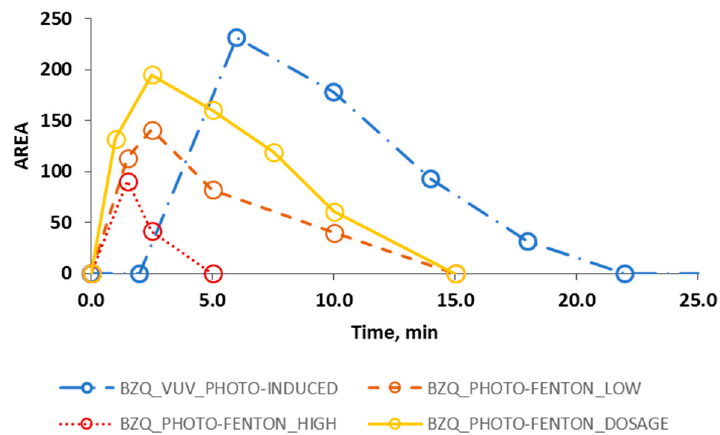
Figure 4. Evolution (HPLC AREA) of the degradation intermediate BZQ ( ○ ) during photo induced oxidation process (line and dots), photo-Fenton process using high (dotted line) and low (dashed line) concentrations of the Fenton reactants and without dosing the hydrogen peroxide, and photo-Fenton process following a H 2 O 2 dosage strategy (solid line).